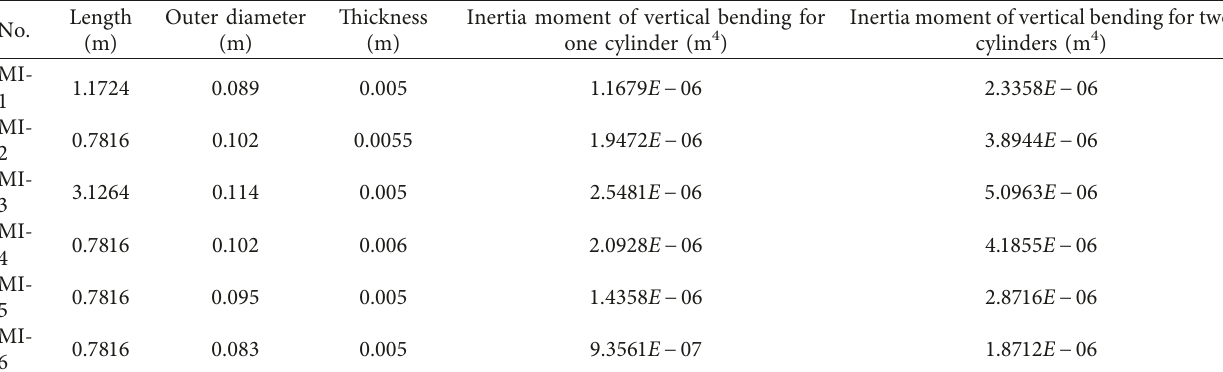
Table 2: Design properties of the backbone along the ship length.